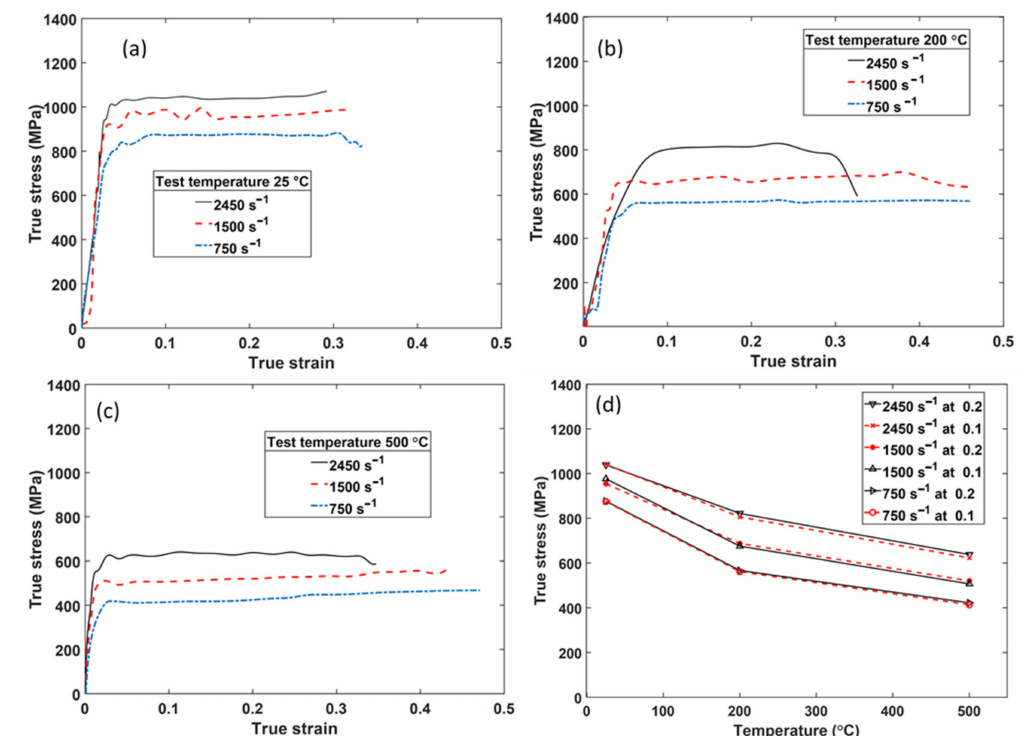
Figure 8. The true stress–strain curves ( a – c ) at different strain rates and temperatures, and ( d ) true stress vs. temperature curves at different strain rates and at strains of 0.1 and 0.2, all for samples D.